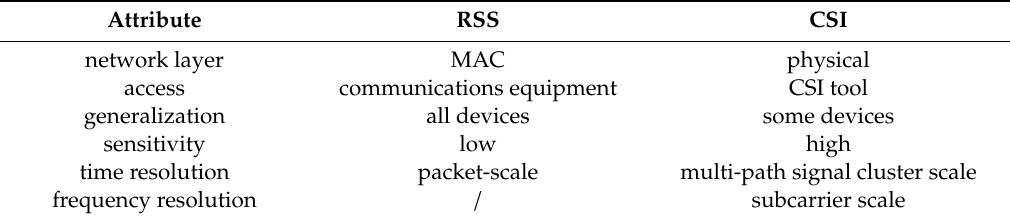
Table 3. Comparison between RSS and CSI